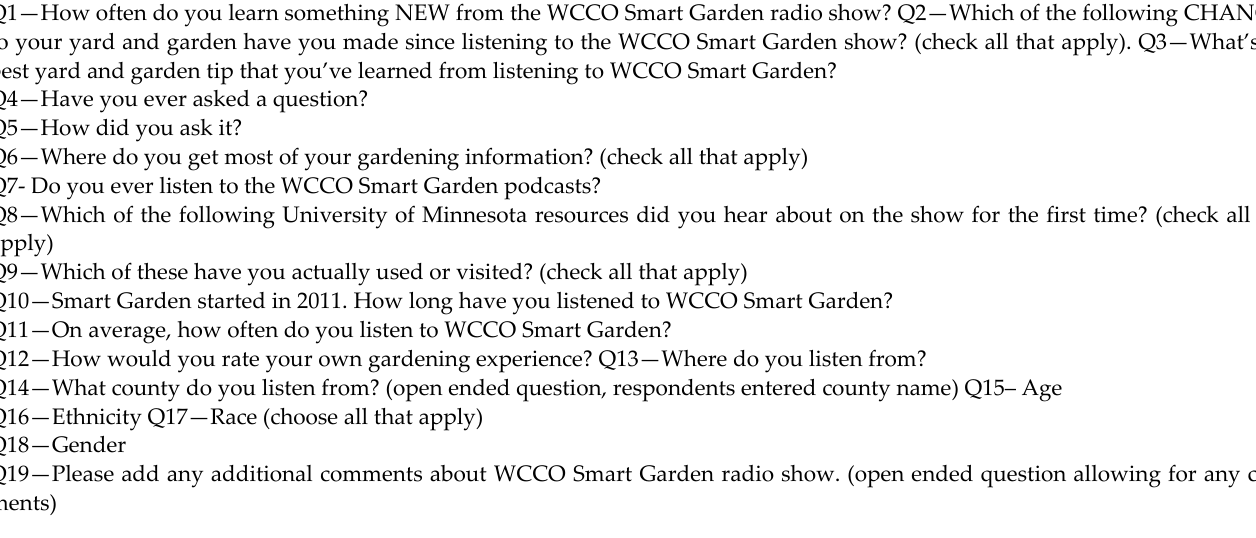
Figure 1. Questions in the online survey used to evaluate the Extension Smart Garden radio show in Minneapolis, MN.